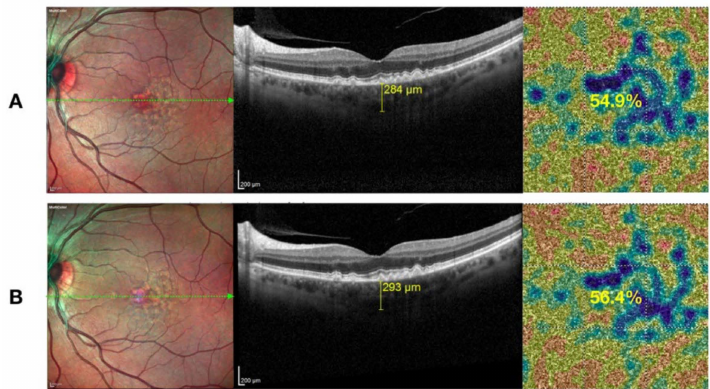
Figure 1. Multimodal retinal imaging of a 69-year-old woman affected by intermediate AMD at baseline and during follow-up. Multicolor imaging showing the presence of drusen and slight pigmentary abnormalities without clinical change at baseline (Panel ( A ), left) and after six months (Panel ( B ), left). SD-OCT scans showing typical drusen as focal deposits of extracellular materials between RPE and BM and choroidal thickness (CHT) measurement changes during the follow- up. Note the improvement of CHT value at baseline (Panel ( A ), middle) and after six months (Panel ( B ), middle). OCTA showing the color-coded flow density map of the choriocapillary vessel density (CCVD) changes during the follow up (the warmer the color, the greater the flow). Note the improvement of CCVD value at baseline (Panel ( A ), right) and after six months (Panel ( B ), right).